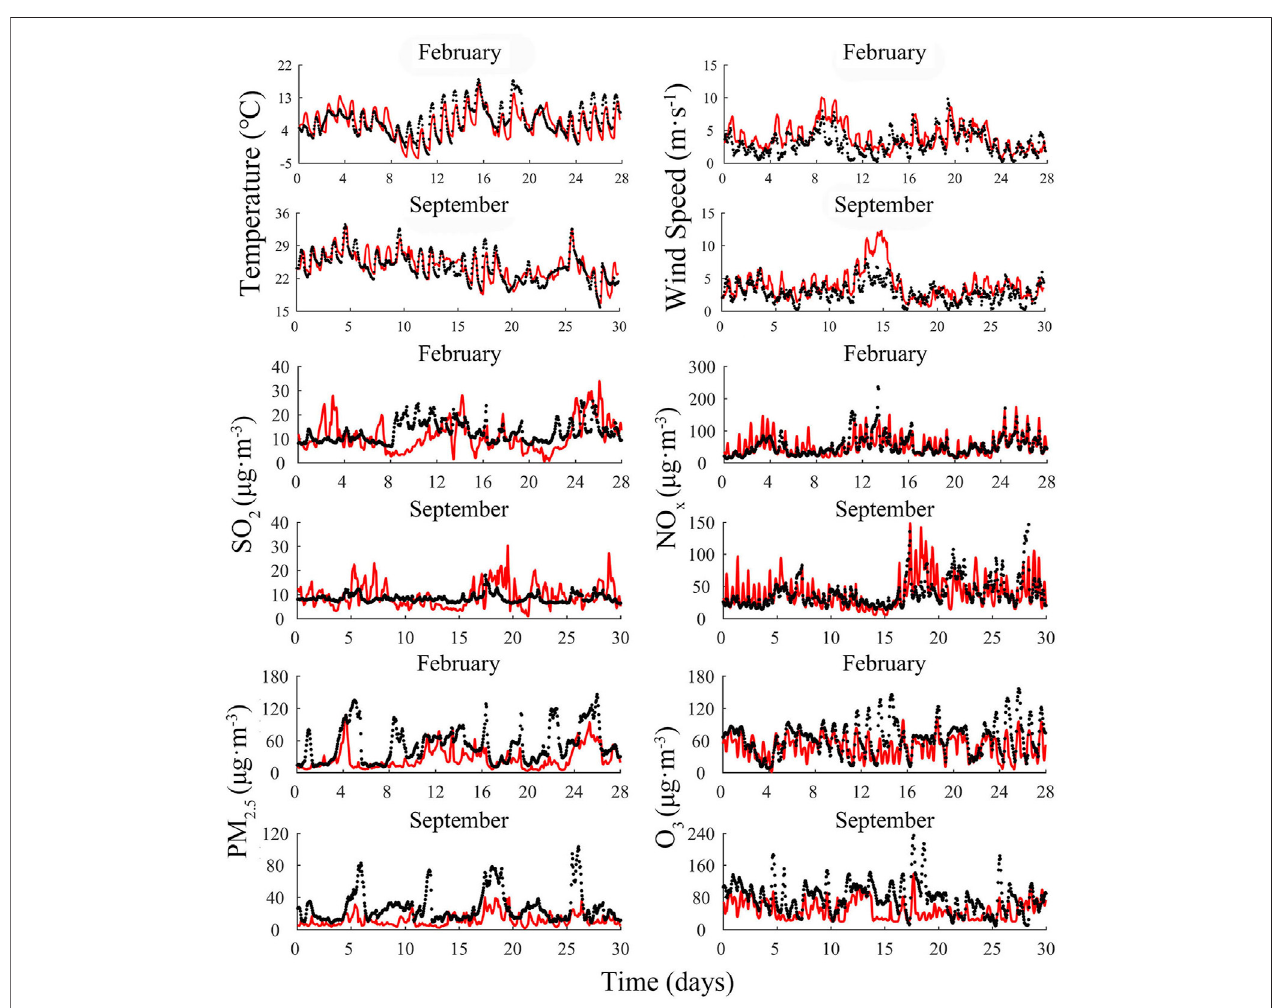
FIGURE 2 | Meteorological parameters (temperature and wind speed) and air pollutants (SO 2 , NO x , PM 2.5 , and O 3 ) comparison of observed (black) and simulated (red) in February and September in 2017.